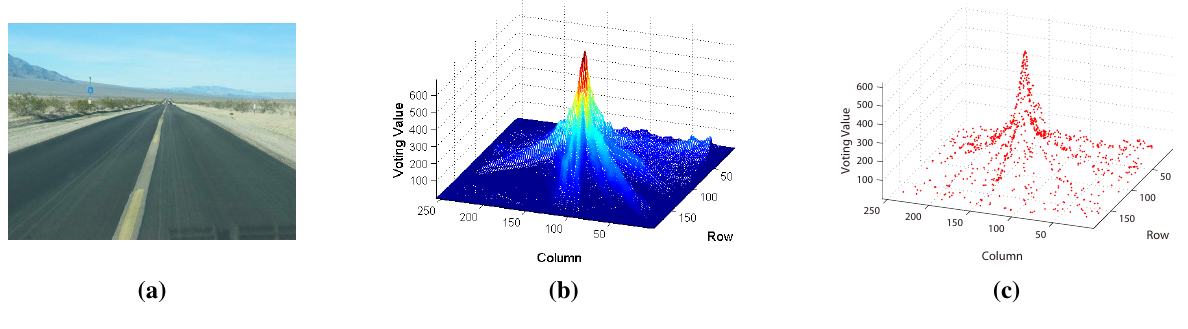
Figure 3. Illustration of voting: ( a ) the original road image; ( b ) the greedy voting map; ( c ) the MPGA voting map.